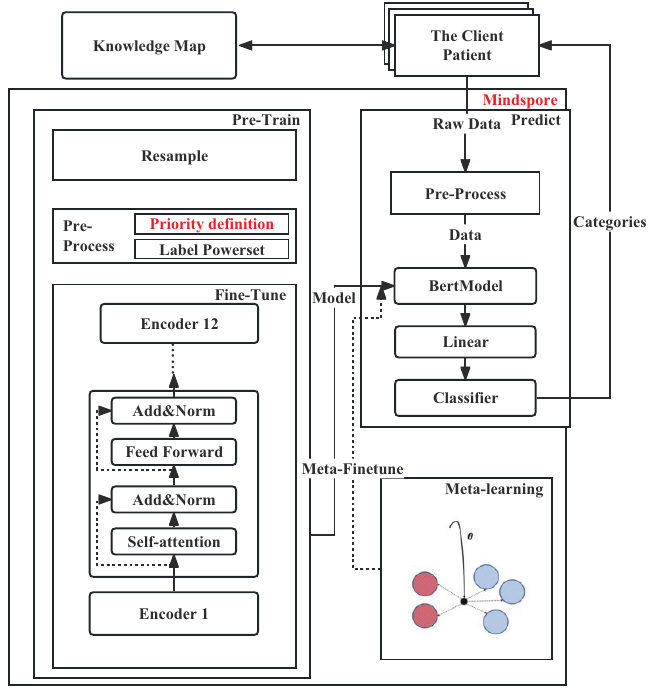
Figure 1. The system